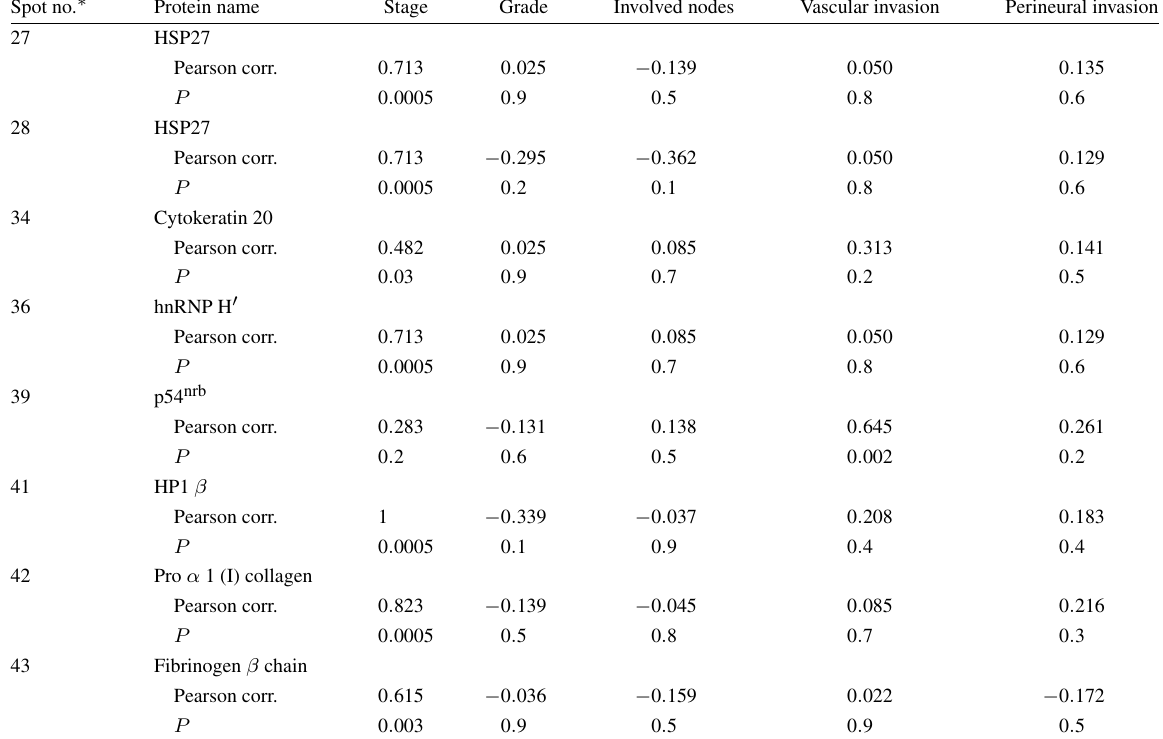
Correlation between identified proteins and clinicopathological